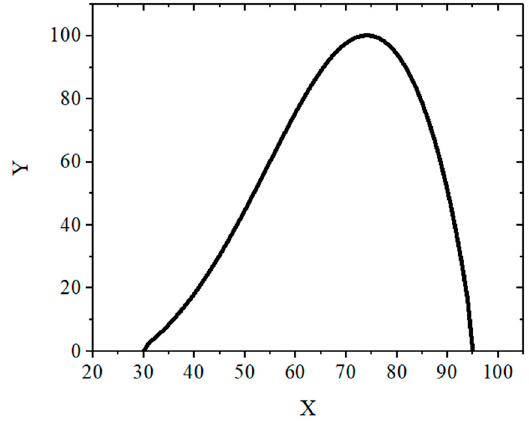
Figure 7. The position coordinates of the edge of the opening angle on the mask.